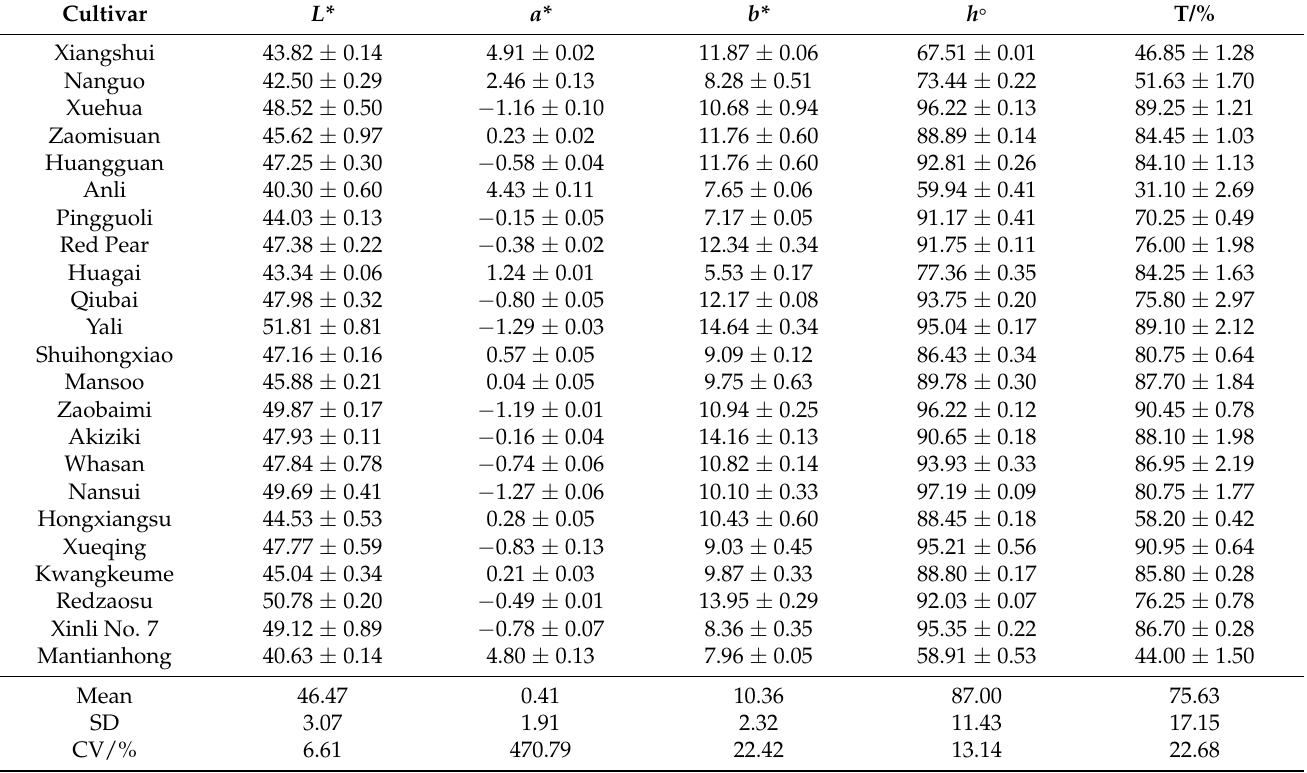
Table 2. Color parameters and transmittance of pear pastes from 23 cultivars.